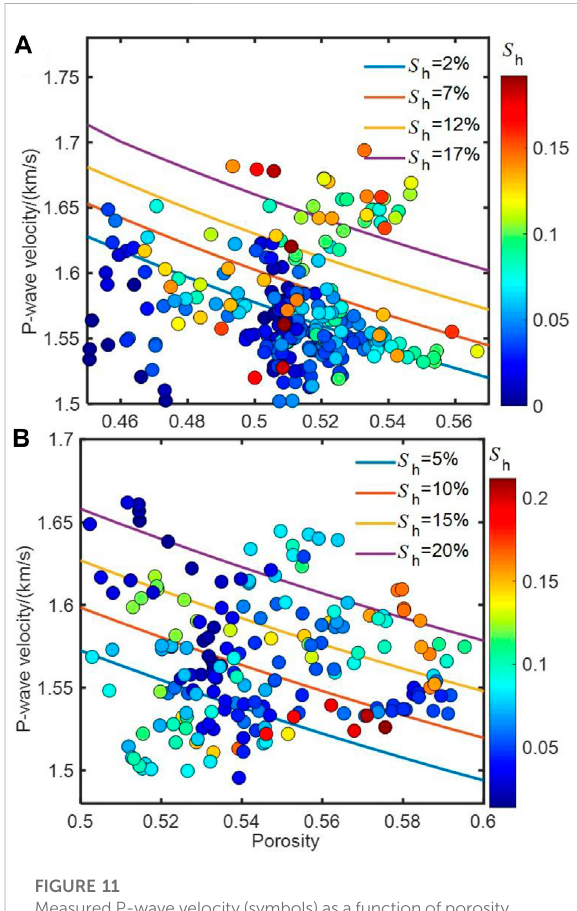
Measured P-wave velocity (symbols) as a function of porosity for different hydrate saturations in wells 1247B (A) and 1250F (B) compared to the model results (solid lines). Measured P-wave velocity data (symbols) compared to the